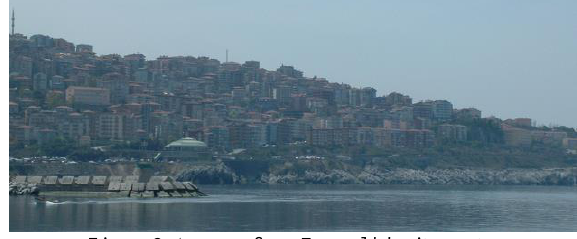
Figure 2. A scene from Zonguldak city centre